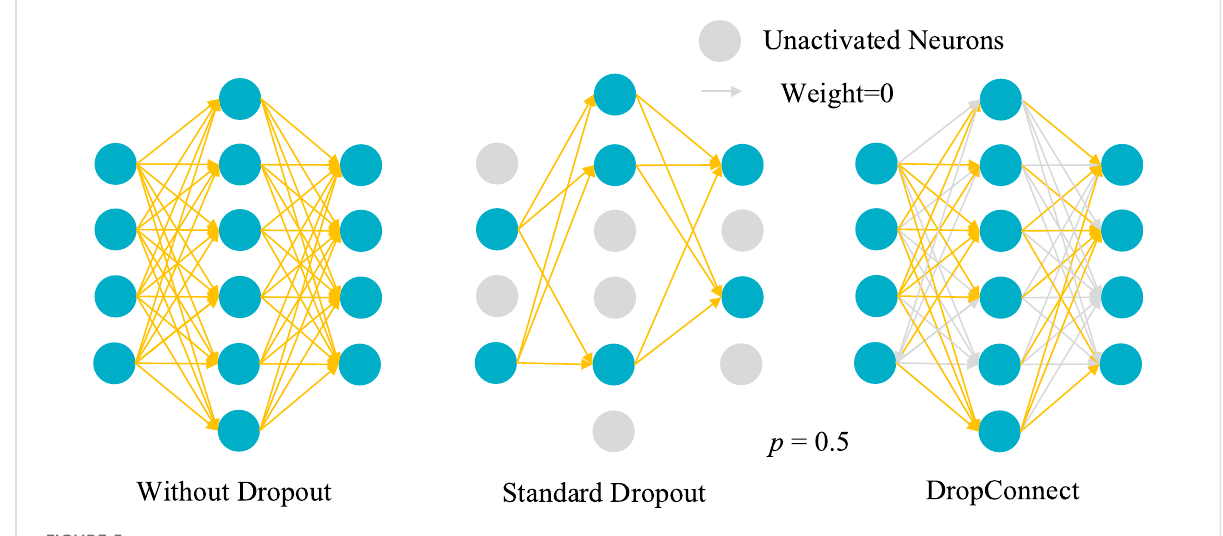
FIGURE 5 When p = 0.5, the Standard Dropout activates only 50% of the neurons, and DropConnect sets 50% of the weights to